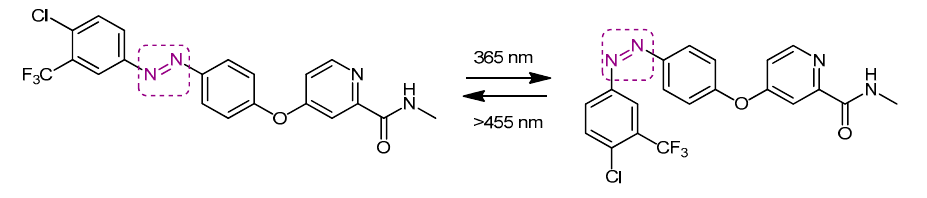
Figure 1. Photoswitchable sorafenib Figure 45. Photoswitchable sorafenib derivative.